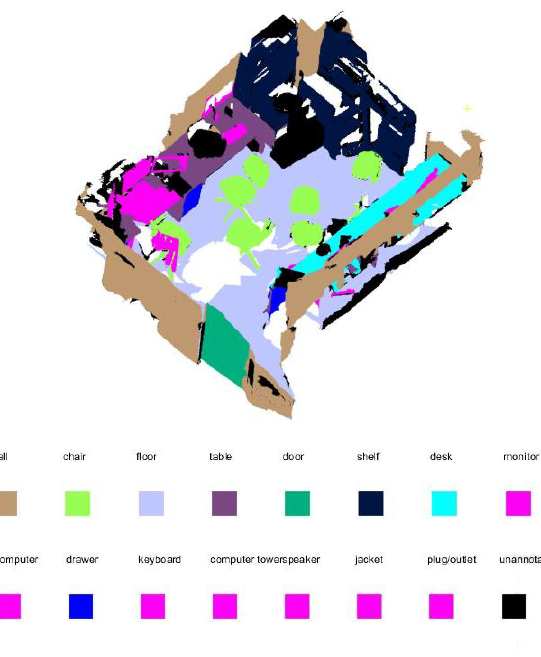
Figure 5. True labels from the benchmark